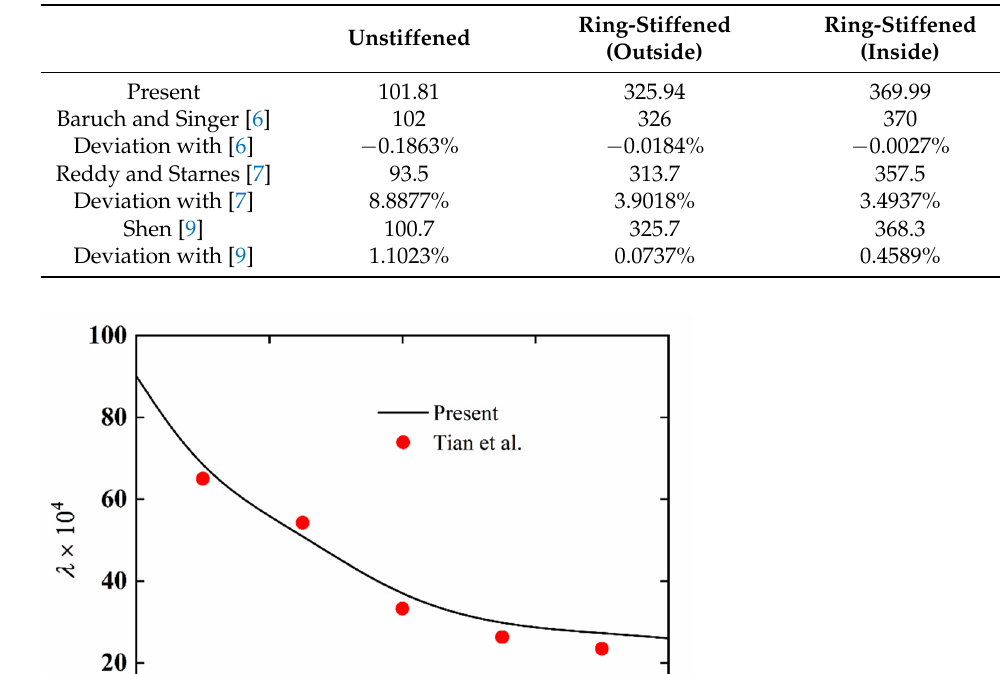
Table 1. Critical pressure (Psi) of homogeneous isotropic ring-stiffened cylindrical shells.